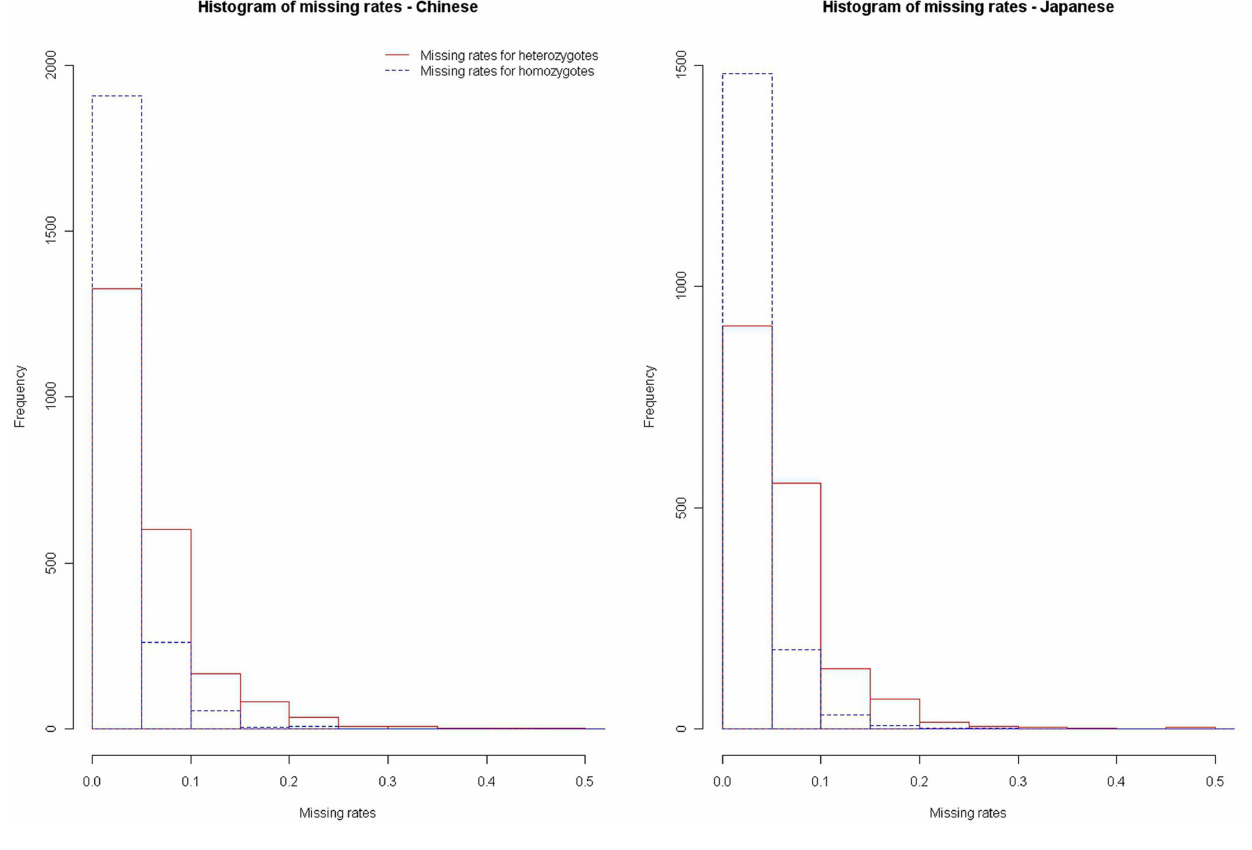
FIGURE 4 | Histograms of missing rates for homozygotes and heterozygotes in the HapMap Chinese and Japanese